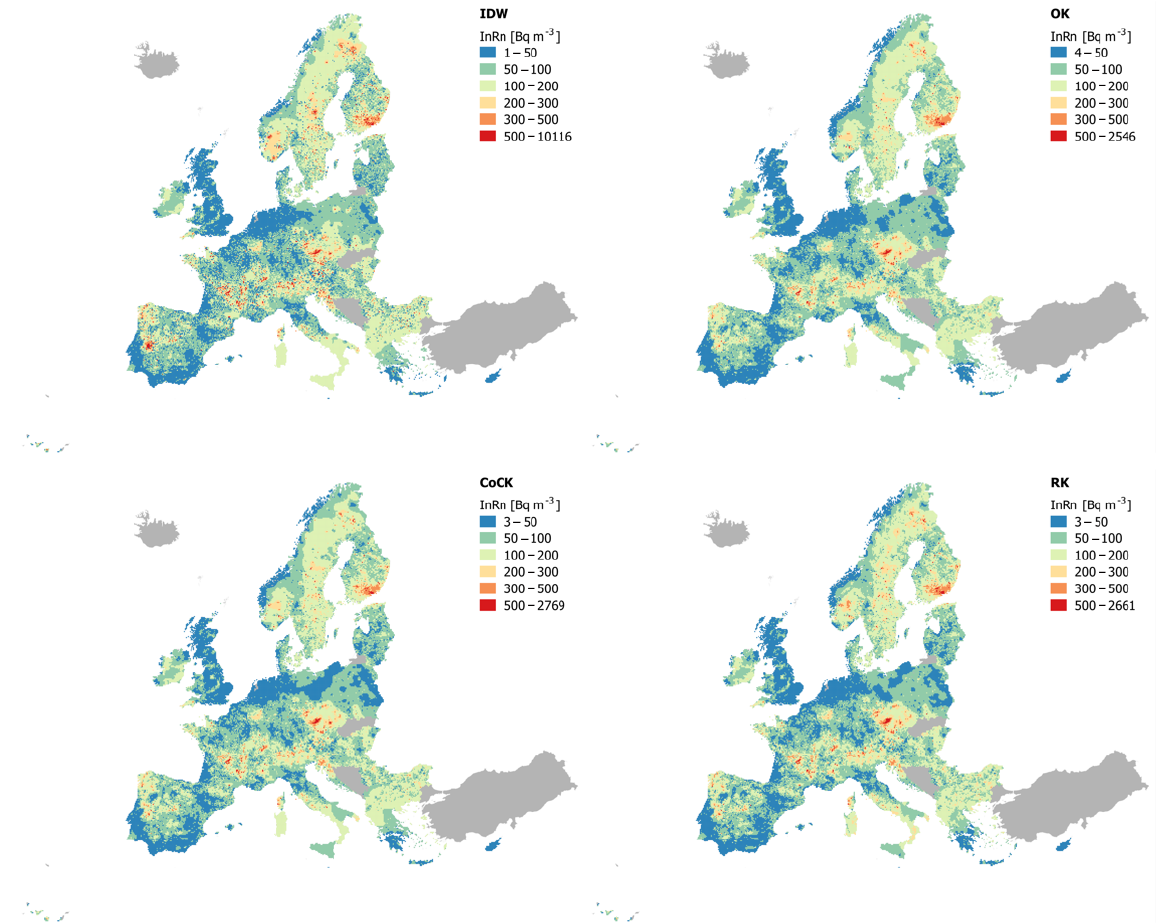
Figure 9. Indoor radon predictions (AM (Bqm − 3 ), ground